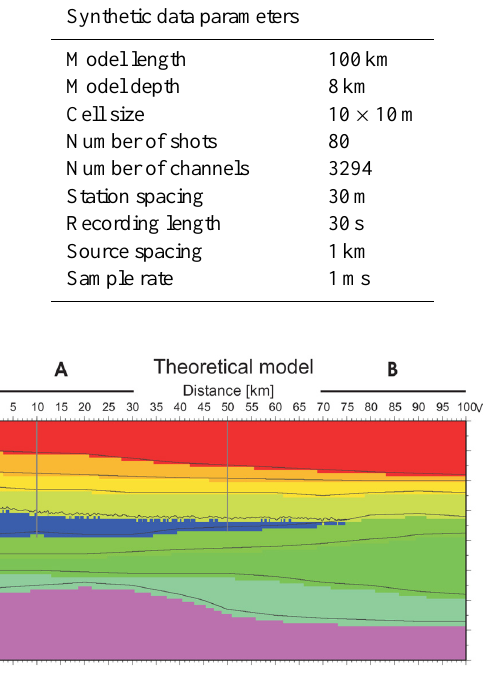
Fig. 1. Synthetic velocity model resampled using 100 × 100m squared cells. The original model used to run simulations was sam- pled by 10 × 10 squared cells. Vertical lines at 10 and 50km show the location of hypothetical wells drilled through the basalt layer. Thus at this points, the thickness of the basaltic wedge was